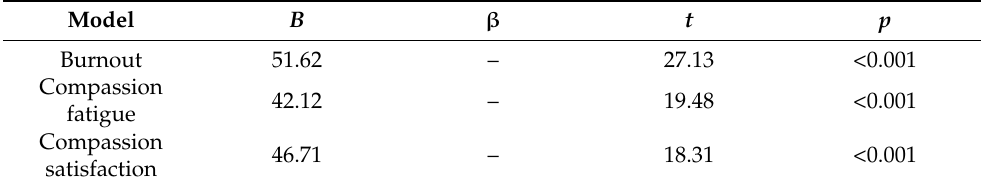
Table 3. Multiple regression analysis